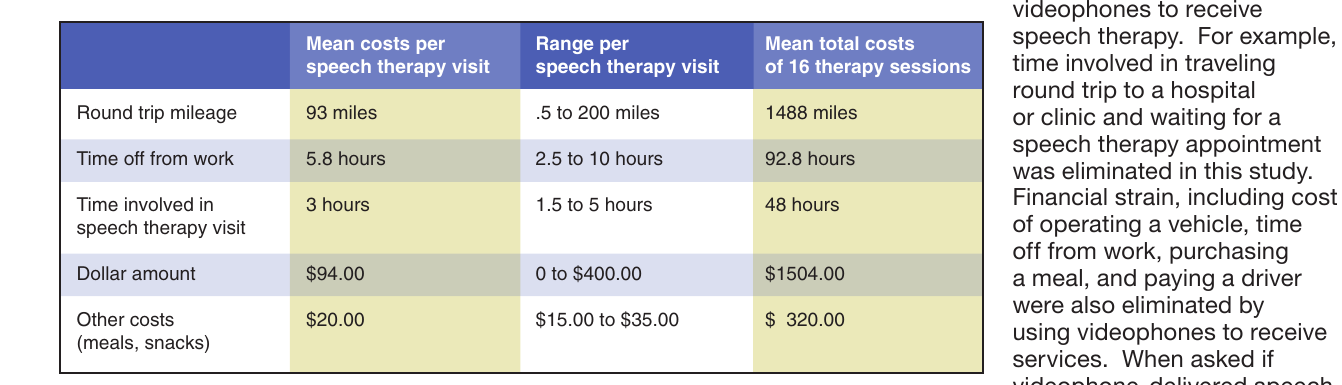
Table 1. Means and ranges of time and money associated with transporting a care-receiver to speech therapy per visit and the total of 16